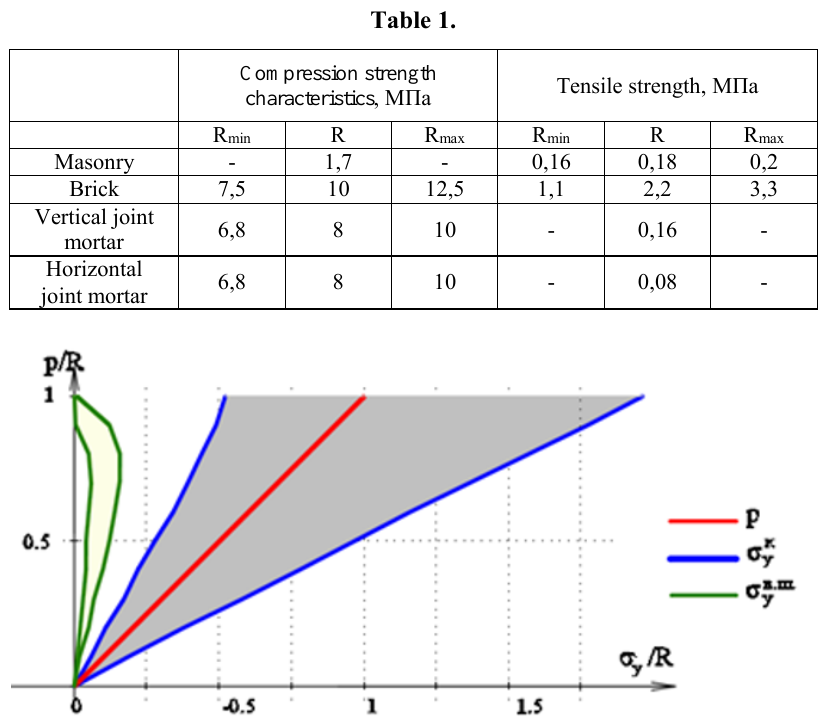
Fig. 4 . Compressive stress dispersion in brick and vertical joint mortar.